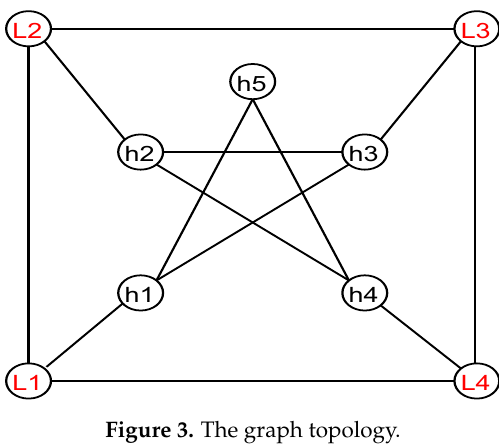
Figure 3. The graph topology.